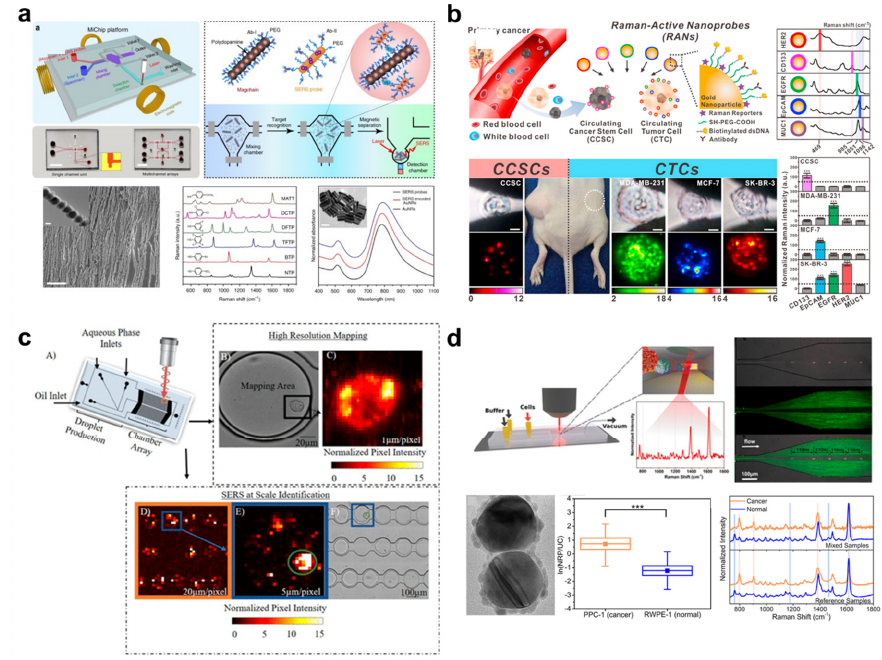
Figure 4. ( a ) Schematic illustration of the Magchain integrated microfluidic chip. This figure is reproduced from [78] (© BY-NC 4.0, 2018); ( b ) Illustration of Raman-active nanoprobe-based circulating cancer stem cell analysis. This figure is reproduced from [70] (© 2018 Elsevier B.V.); ( c ) Illustration of a single-cell encapsulation event within the microfluidic device. This figure is reproduced from [79] (© 2018 American Chemical Society); ( d ) Graphical depiction of device layout and flow dynamics. This figure is reproduced from [80] (© 2015 American Chemical Society).